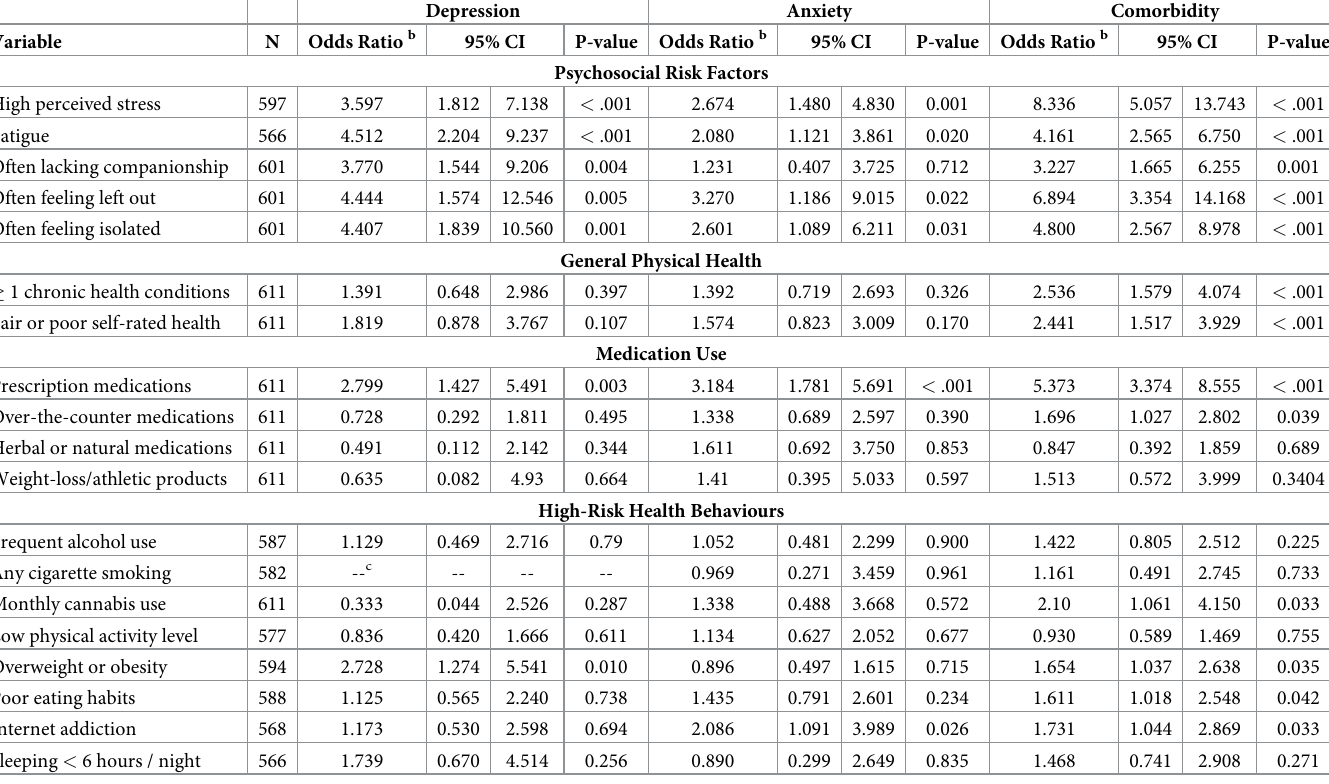
Table 2. Adjusted odds of psychosocial risk factors, general physical health indicators, medication use, and high-risk health behaviours among individuals with depression, anxiety, and comorbidity compared to those without mental illness a